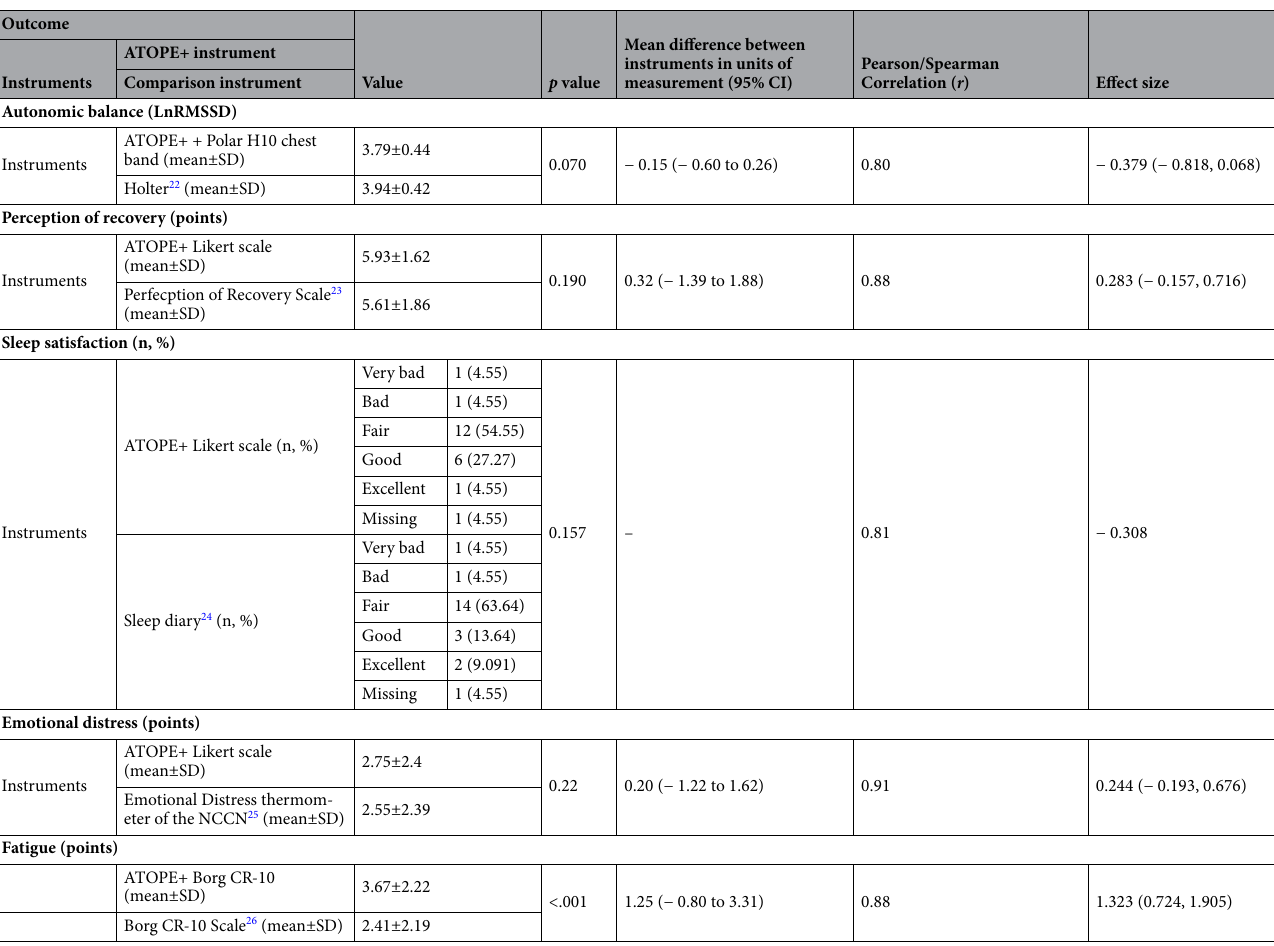
Table 5. Indices of validity for ATOPE+ mHealth system in BCS (N = 21). LnRMSSD mean square root differences of the standard